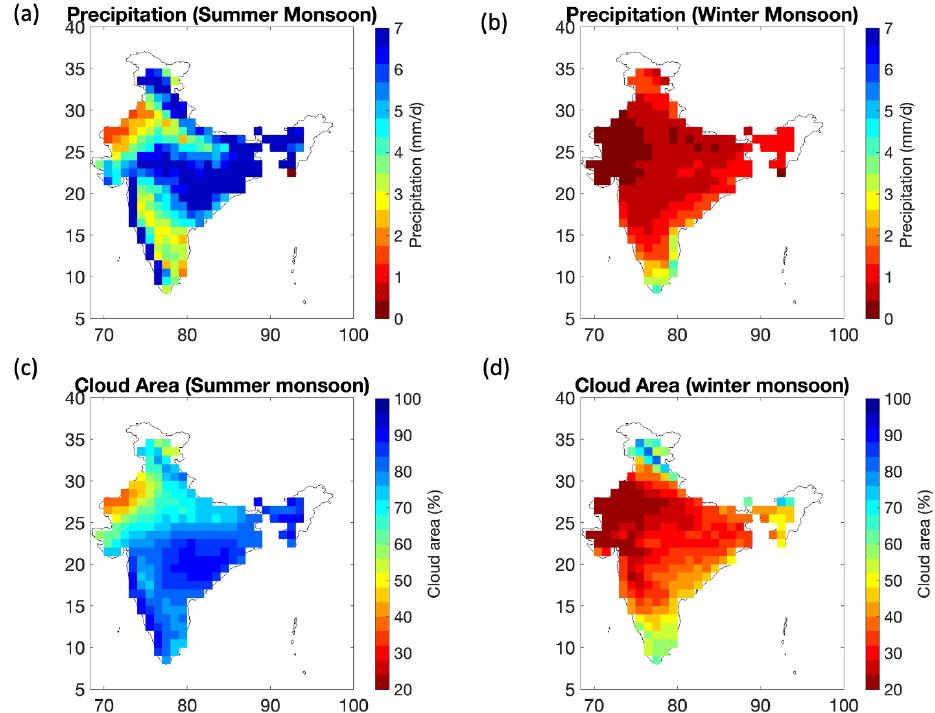
Figure C1. Maps of the mean daily precipitation (from IMD) and cloud area fraction (from NASA-CERES) during (a, c) the summer monsoon (April–September) and during (b, d) the winter monsoon (October–March).